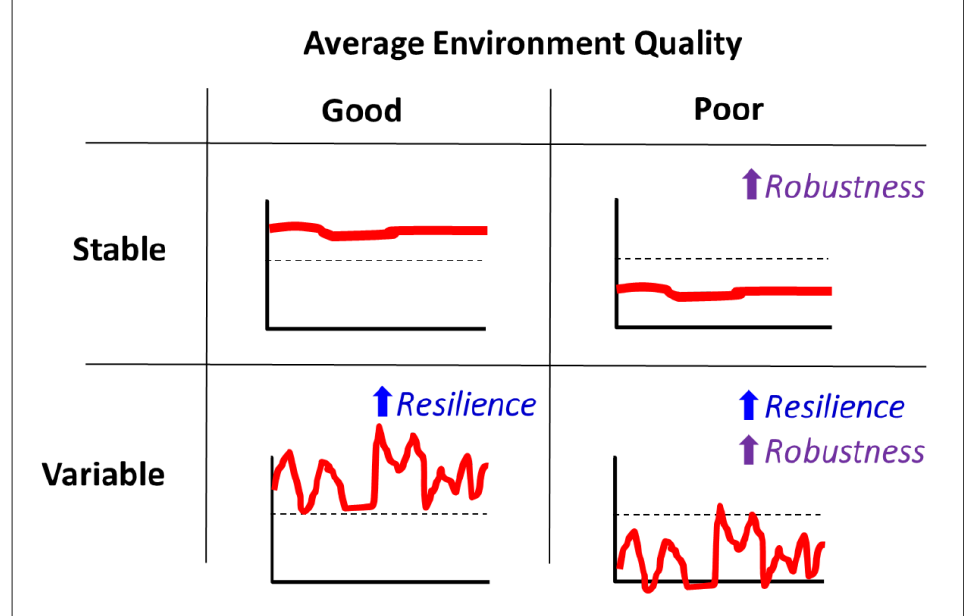
Figure 1: Schematic representation of environment quality (y-axis in the insert graphs) through time (x-axis in the insert graphs), the solid red lines represent the environmental quality (the dotted line shows the same reference level for the 4 insert graphs). The four combinations of environments that are on average good or poor, and stable or variable are shown. The need for animal robustness and/or resilience is indicated for each